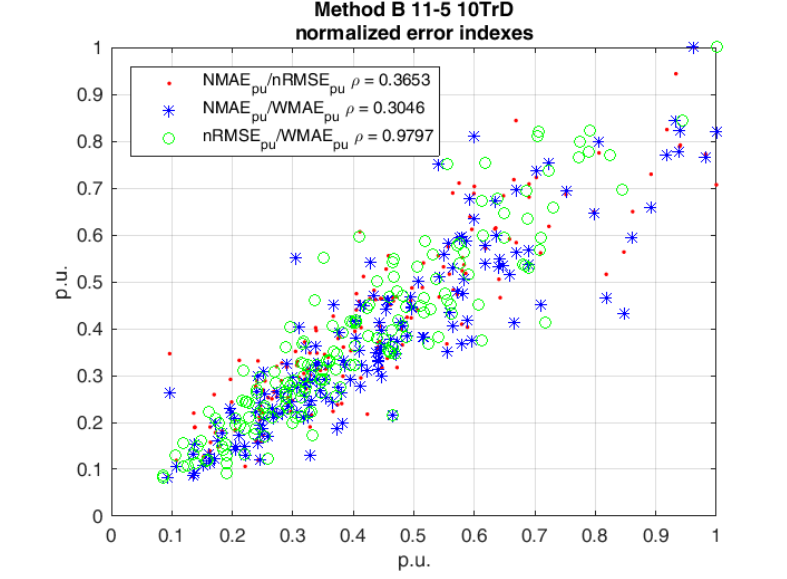
Figure 8. Normalized daily errors correlated in a